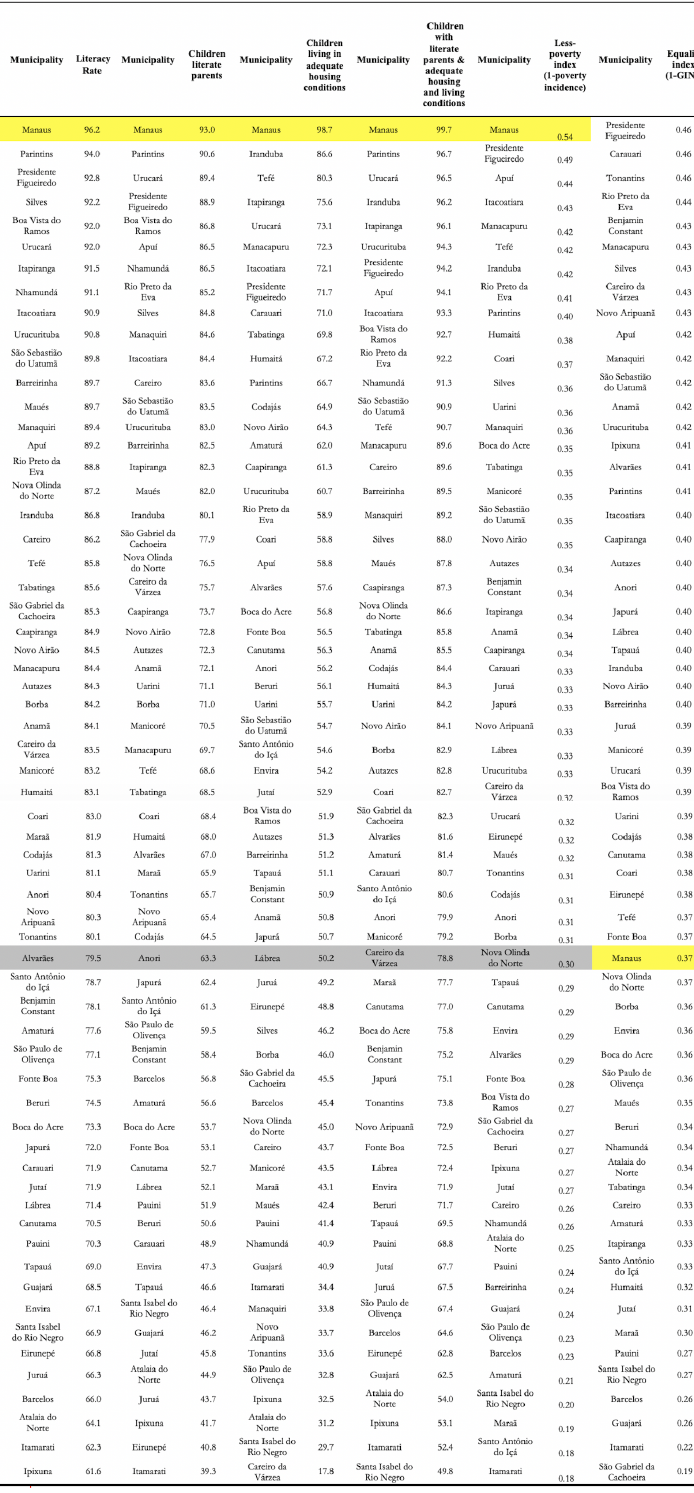
Table 15: Ranking of Social Indicators of Amazonas